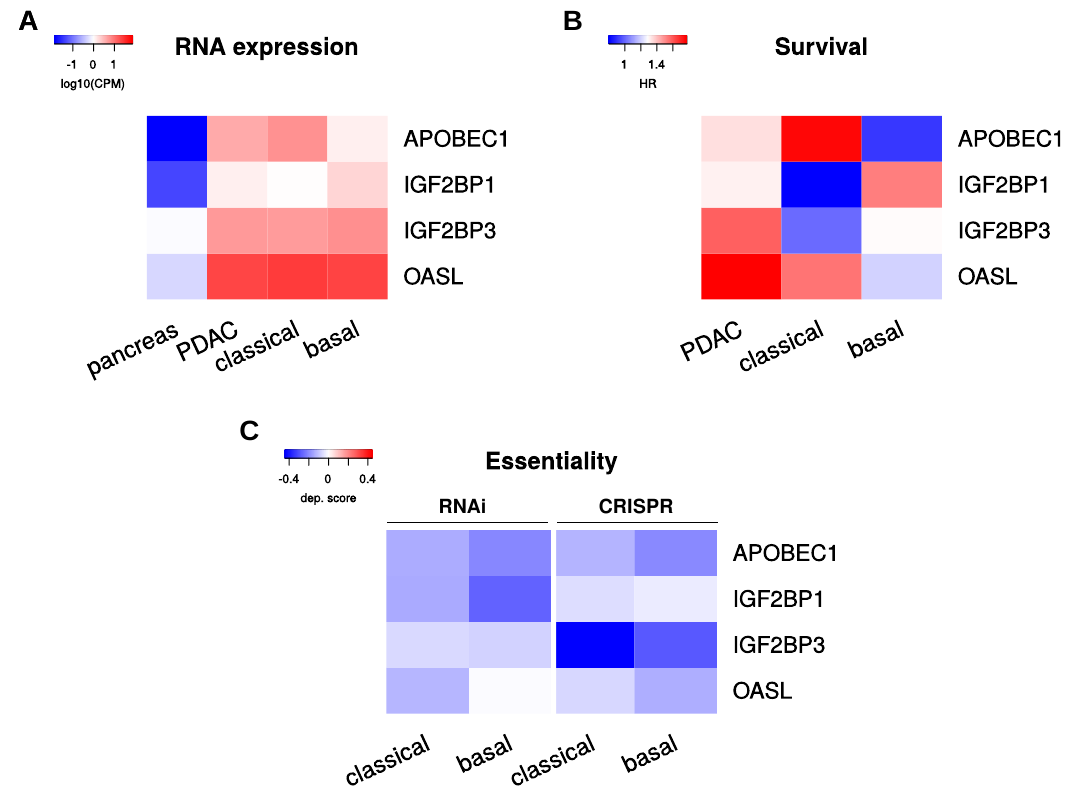
Figure 6. Selected PoRs. ( A ) Average normalized RNA expression values (log10 CPM) of the four selected PoRs in pancreas and PDAC samples comprised of the whole (PDAC) tumor sample set as well as subtype specific subsets. ( B ) Hazard ratios (HR) of the four selected PoRs determined from overall survival rates between low and high RNA expression. ( C ) Average dependency scores of the four selected PoRs obtained from RNAi-derived depletion as well as CRISPR-derived deletion in classical and basal-like PDAC derived cell